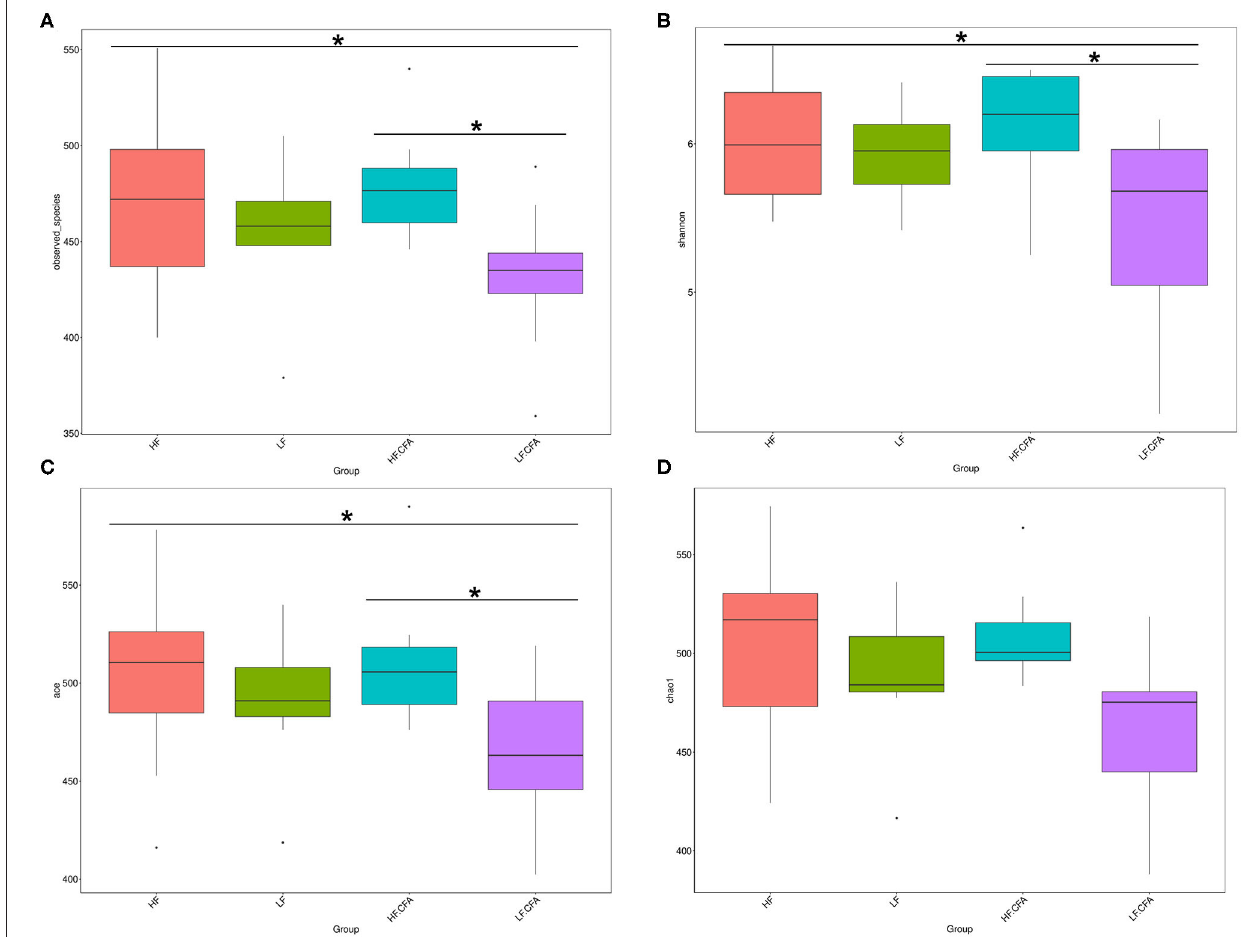
FIGURE 5 | Microbiota alpha-diversity comparison among four groups, Piglets were regarded as the experimental units, each treatments with n = 9 except that HF.CFA with n = 8 due to a sample was eliminated. (A–D) Observed_species, Shannon index, ACE index, and Chao 1 index of four groups, respectively, HF, High fiber, no CFA; LF, Low fiber, no CFA; HF.CFA, High fiber with CFA challenge; LF.CFA, Low fiber with CFA challenge. *means P <